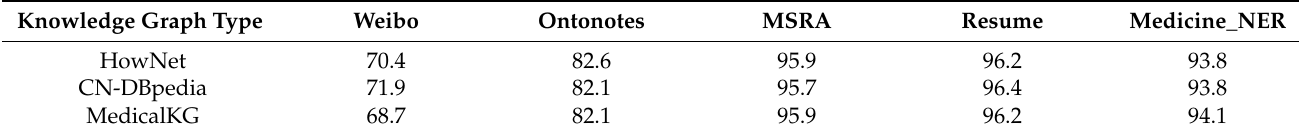
Table 4. Comparison of different knowledge graphs ( F 1).